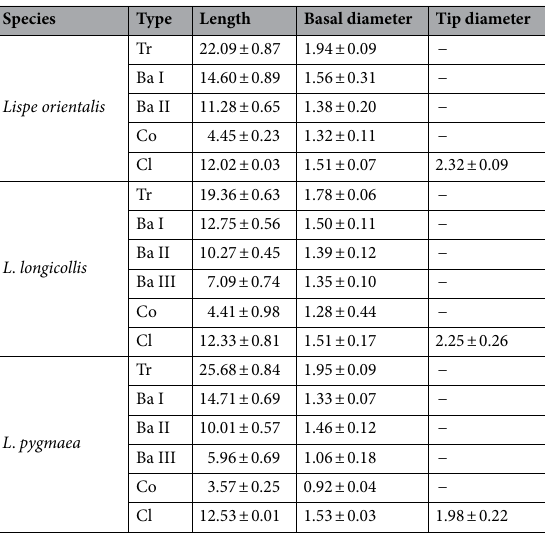
Table 2. Length, basal diameter, and tip diameter (Cl only) of sensilla on antennal postpedicel of three Lispe species (μm ± SD, n = 10). Ba I basiconic sensilla I, Ba II basiconic sensilla II, Ba III basiconic sensilla III, Cl clavate sensilla, Co coeloconic sensilla, Tr trichoid sensilla, − undetermined.